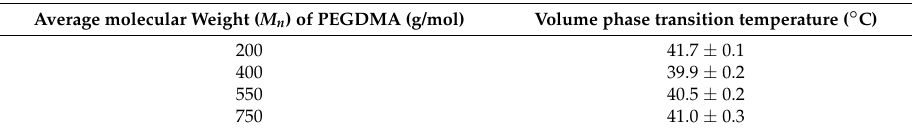
Table 3. VPTT values for samples with PEGDMA 200, 400, 550 and 750 (g/mol). Average molecular Weight ( M n ) of PEGDMA